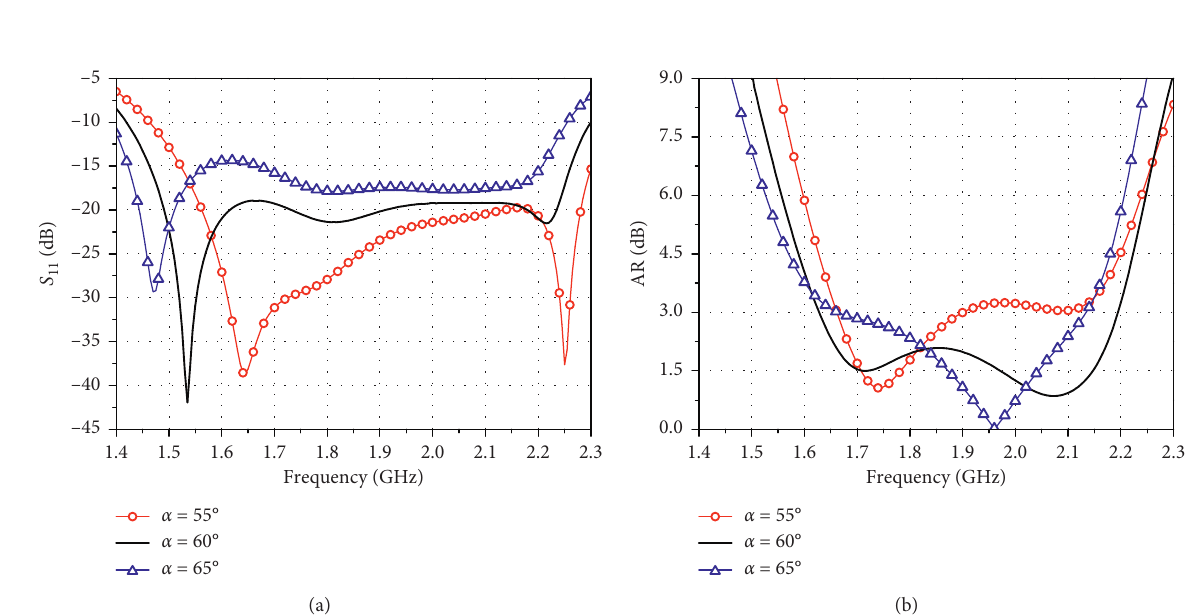
Figure 7: Effects of the angle α on (a) S